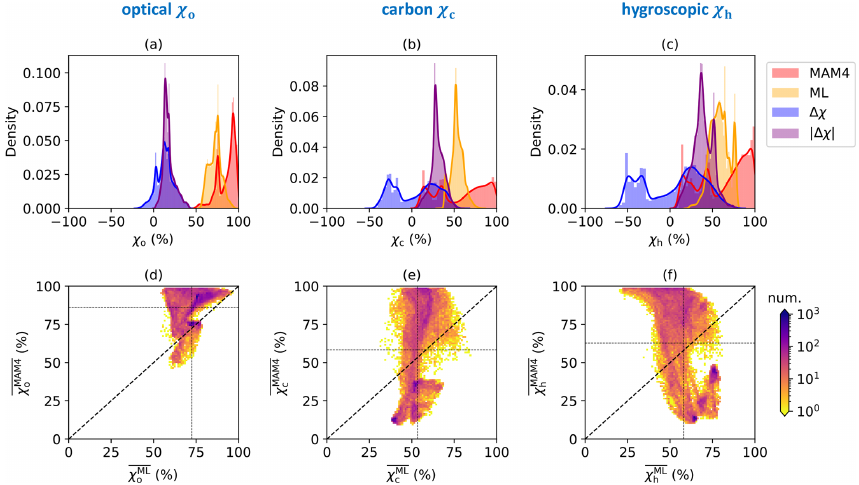
Figure 2. Probability density functions of annual averaged mixing state indices using the MAM4 model and ML model. The thin black lines refer to their mean values.